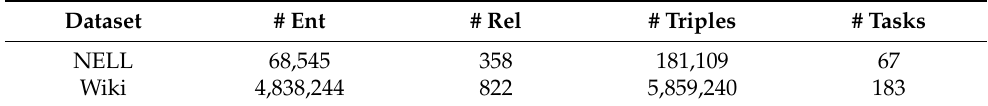
Table 2. Statistics of the NELL and Wiki